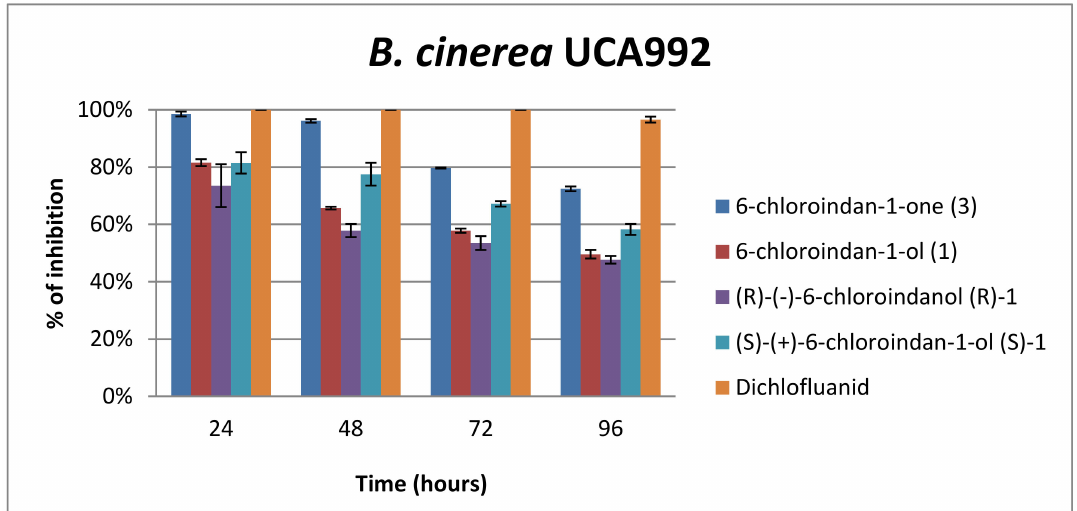
Figure 1. Results of antifungal bioassays for 6-chloroindanol ( 1 ) derivatives at 100 µ g / mL.